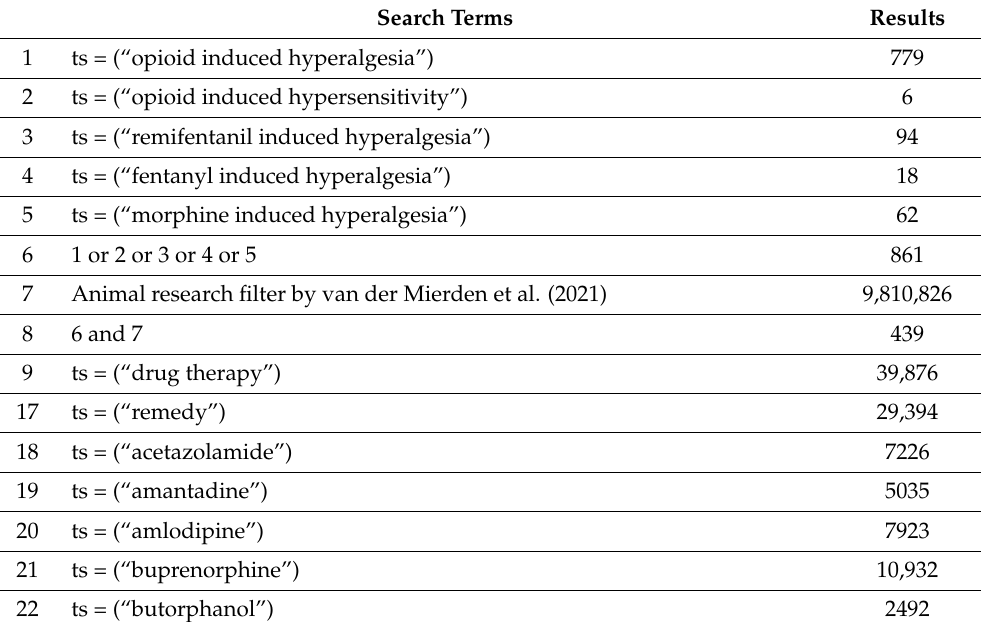
Table A7. Web of Science search strategy development (via Clarivate). The number of records retrieved for search items in Web of